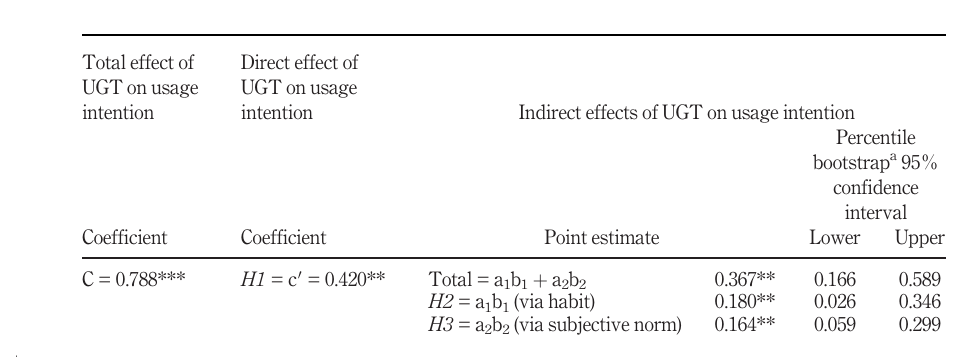
Table VIII. Mediation effect analysis